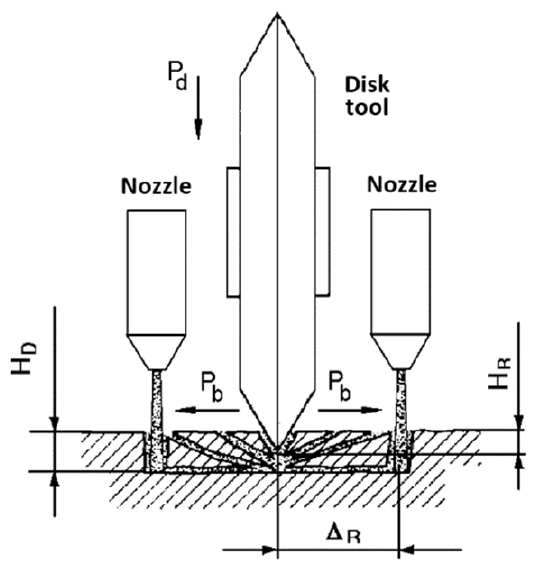
Figure 7. Diagram of mining with a disk tool assisted by HPW jets, applied on a Wirth TBM, model TB-I-260 [7,23]. H R —disk penetration depth, H D —depth of slots cut with water jets, Δ R —distance of the nozzle axis from the plane defined by the edge of the mining disk.